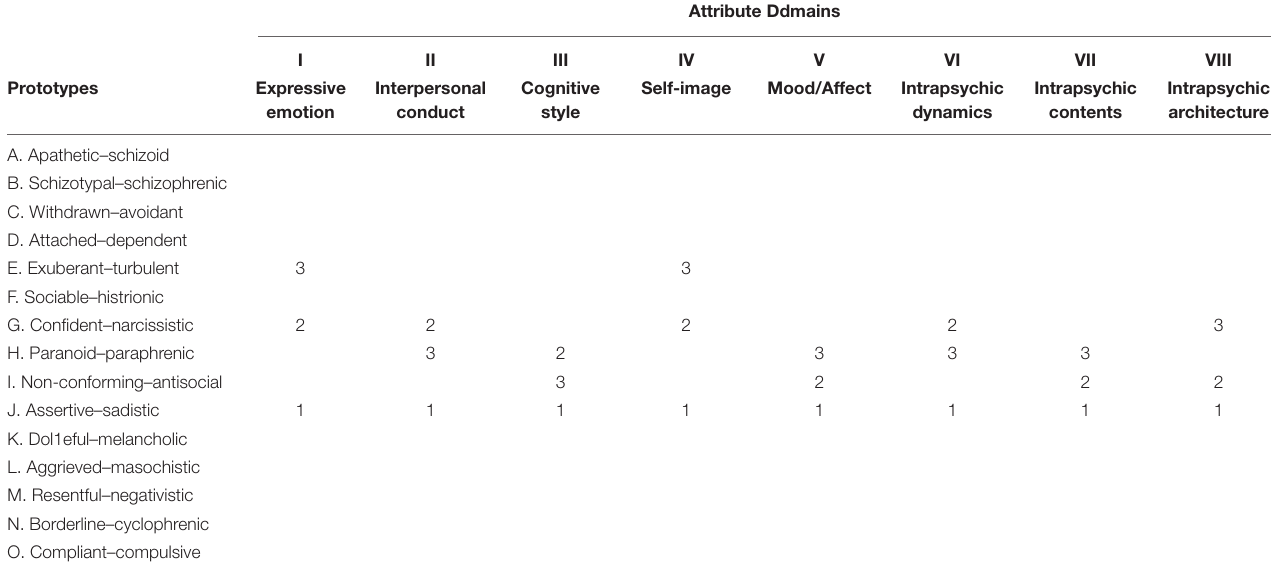
TABLE 3 | Piëch’s spectrometer